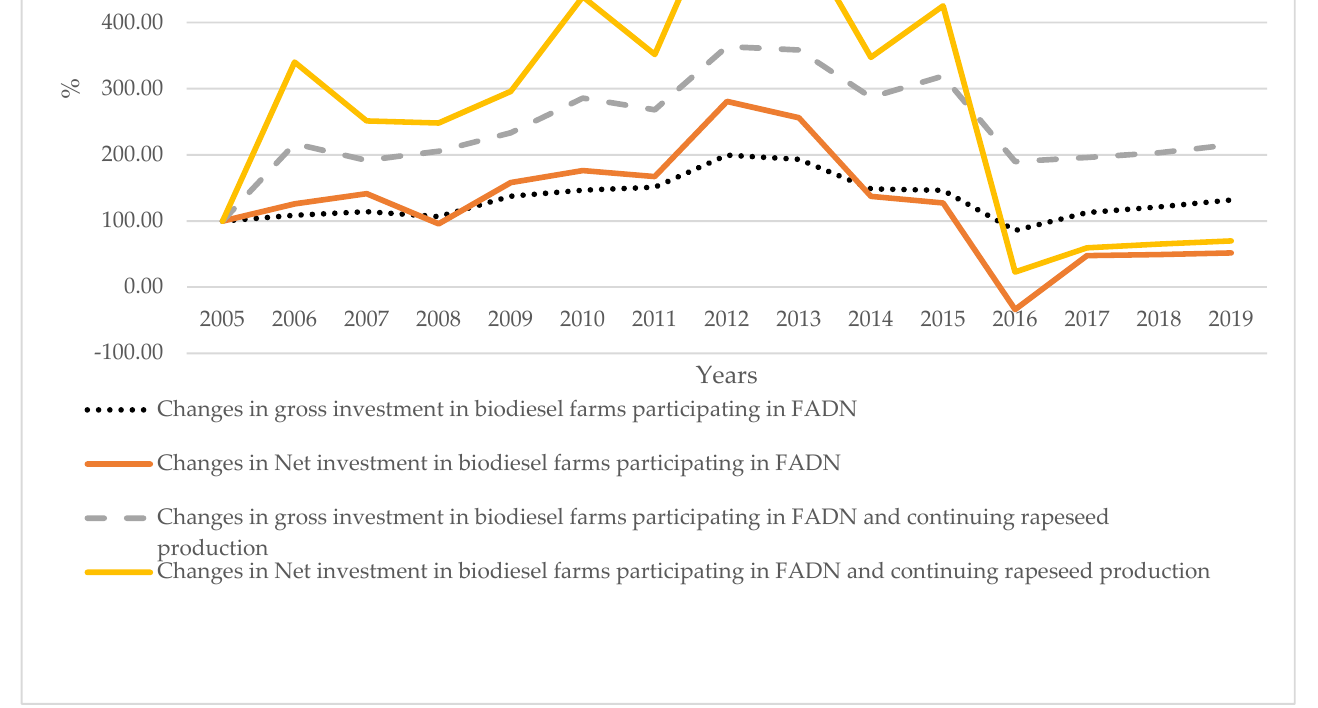
Figure 6. Changes in investments in Polish biodiesel farms in 2005–2019 [%]. Source: own elaboration based on FADN data [52].